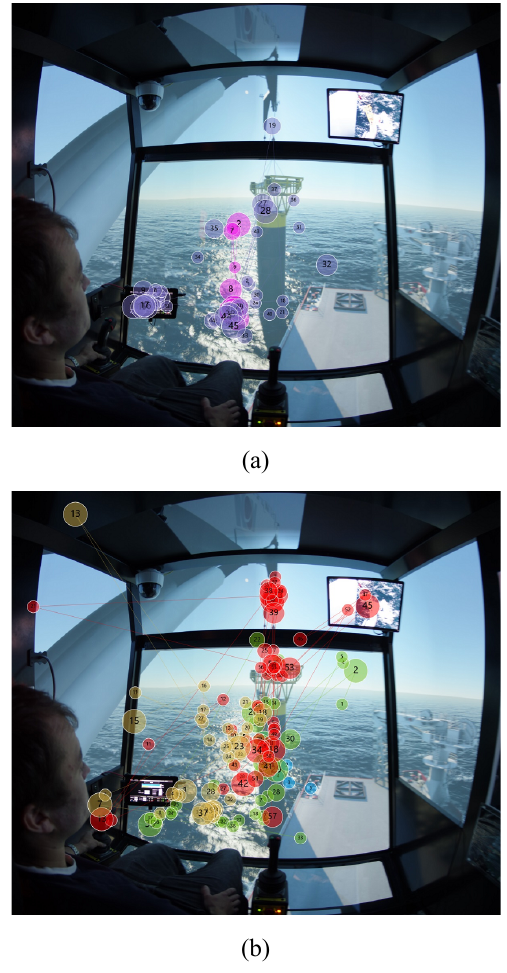
Figure 8: Scanpath for (a) experts and (b) novices in target stage one.